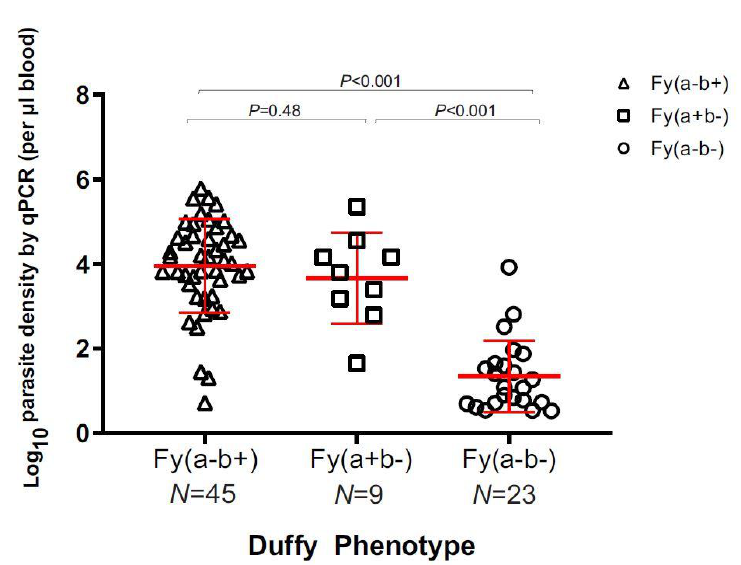
Figure 2. Estimated log parasite density per μL of blood based on Duffy phenotype. There was no significant difference between Fy(a-b+) and Fy(a+b-) phenotypes, but there was a significant difference between the Fy(a-b-) phenotype and the Fy(a-b+) and the Fy(a+b-) phenotypes ( p < 0.001). For a subset of 77 P. vivax samples, the average age of Fy(a-b-) individuals was similar to those of Fy(a-b+), but significantly younger than those of the Fy(a+b-) phenotype (Figure 3A, File S2).